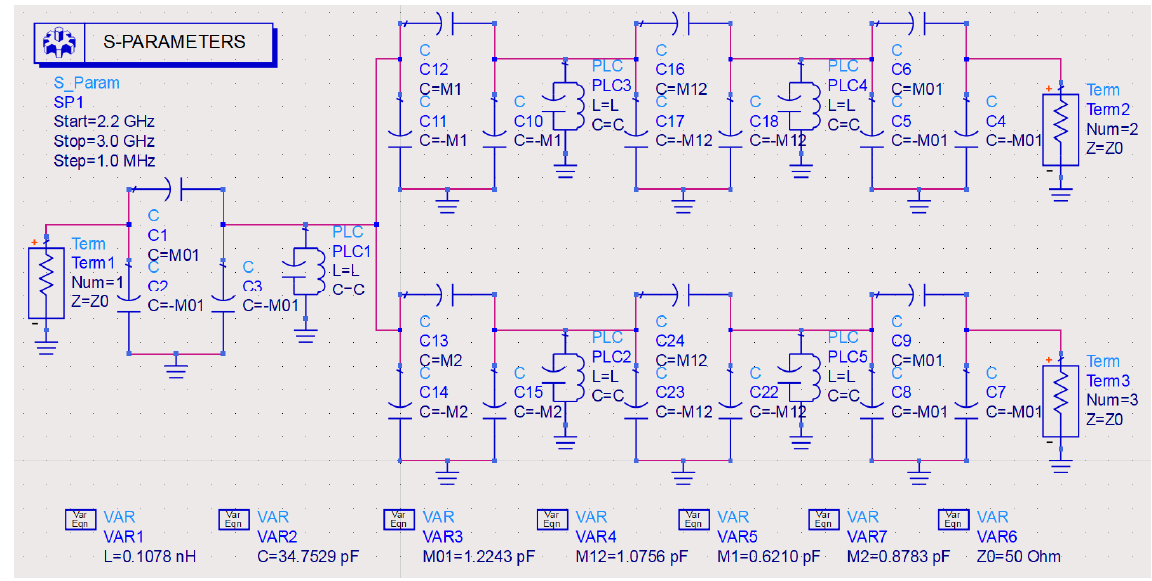
Figure 2. Circuit model with J-inverters as capacitor-only network.